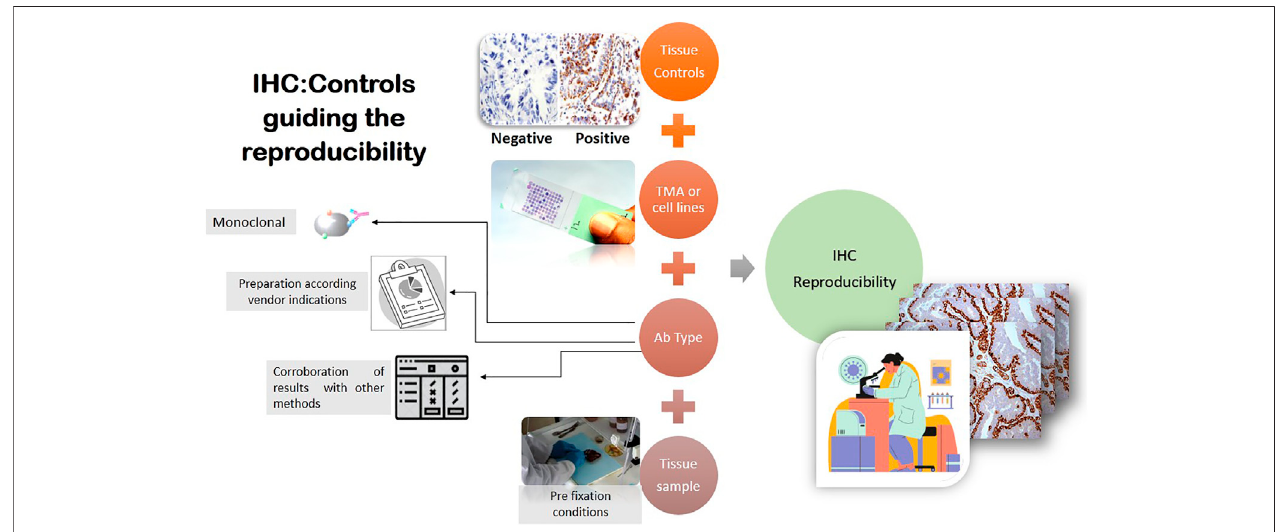
FIGURE2| Picture (A) showsapositivemembranestaininginPD-L1inclearrenalcellcarcinoma.Picture (B) expressescytoplasmicstainingthatisnotconsidered positive in the evaluation. C and D are false positive because both are expressing the marker in in fl ammatory cells or macrophages.